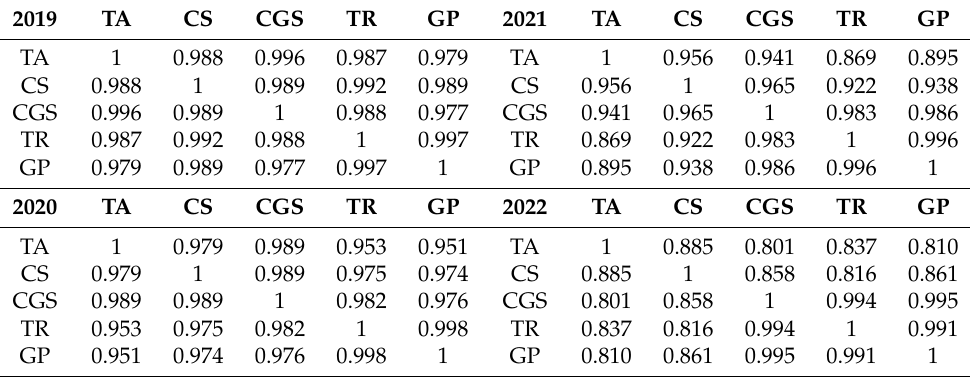
Table A10. Pearson correlation coefficient